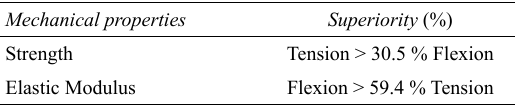
Figure 6. Global comparison diagram - resistance and stiffness. Table 4. Influence of hybridization method on laminate HSCL specimens.